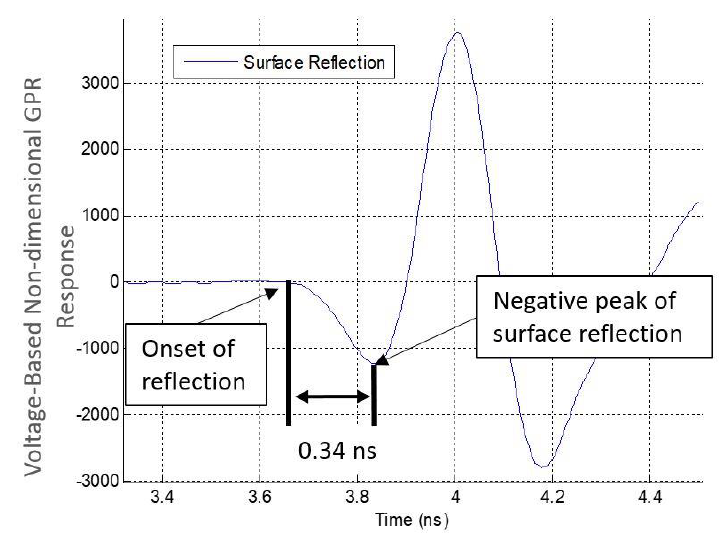
Figure 6. Isolated reflection from surface reflection indicating the time length of interest is about 0.34 ns and is measured from the onset of the reflection to the negative peak.